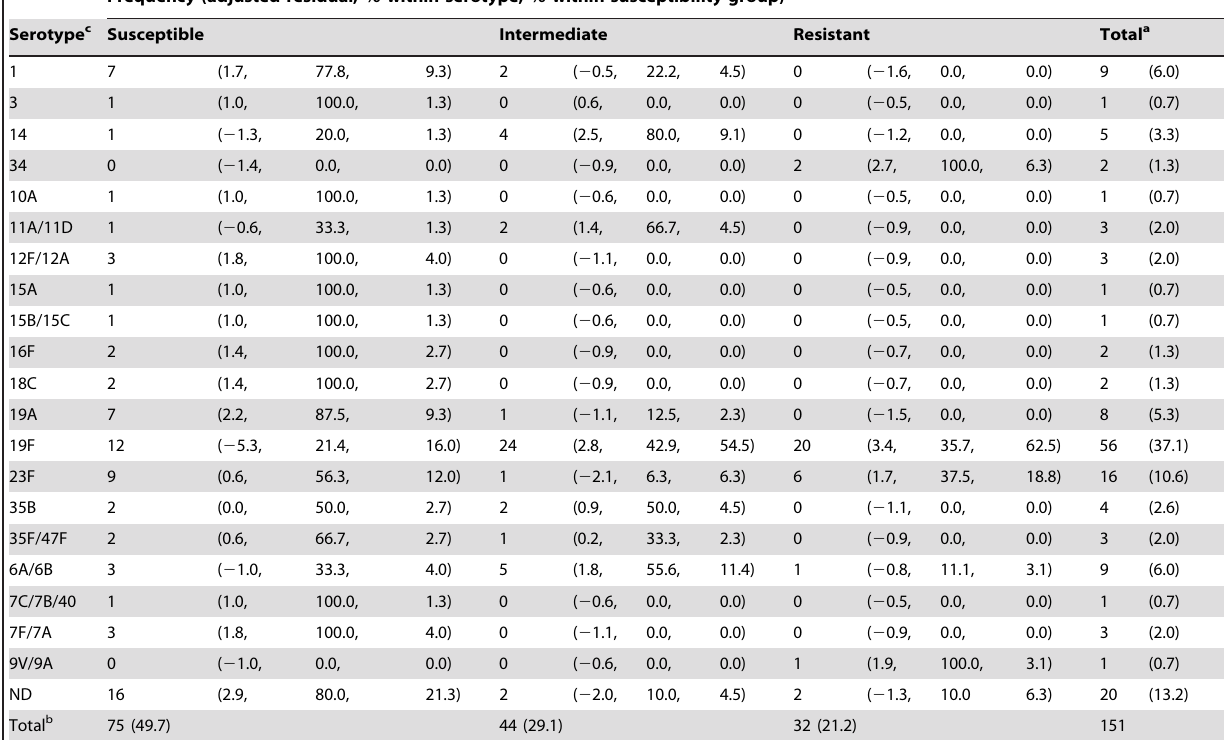
Frequency (adjusted residual, % within serotype, % within susceptibility group) Serotype c